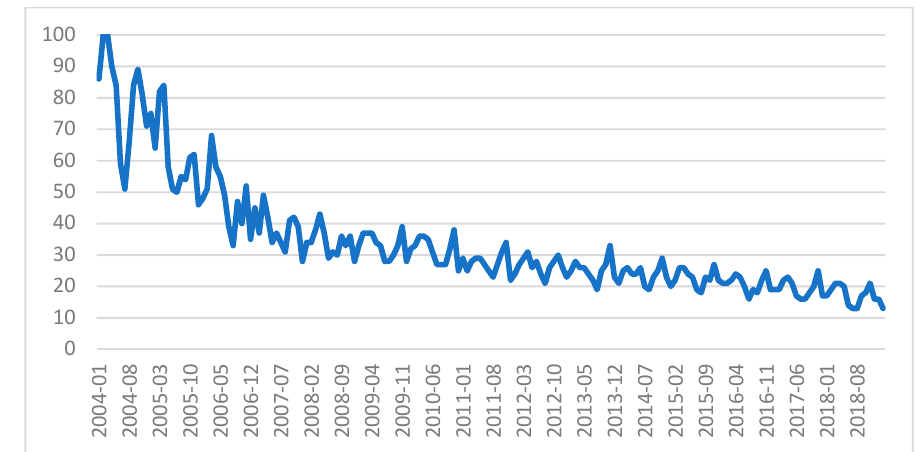
Figure 3. Data source: www.google.com/trends, retrieved 5 February 2019.